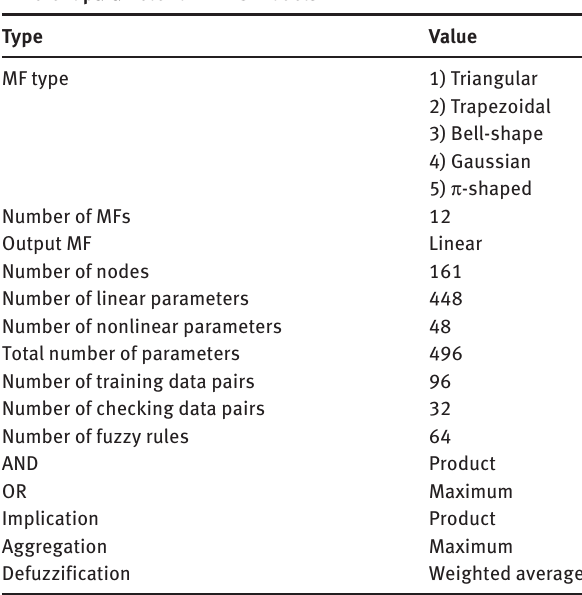
Table 6 Different parameter types and their values used for ANFIS models.